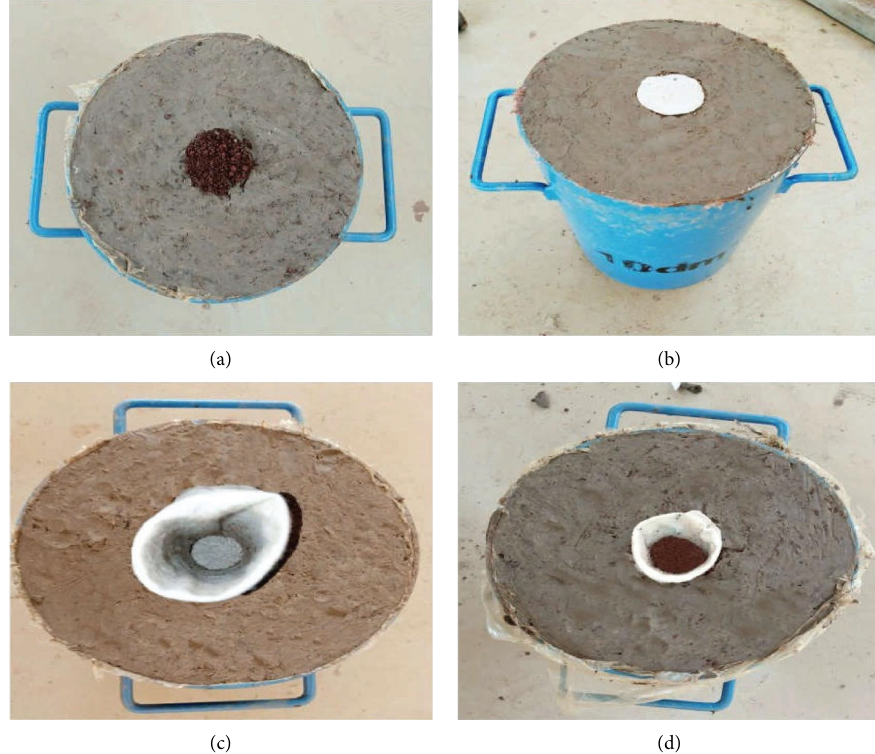
Figure 8: (a) Unreinforced CGC, (b) HRCGC, (c) HVRCGC (horizontal-vertical reinforced cinder gravel column), and (d)